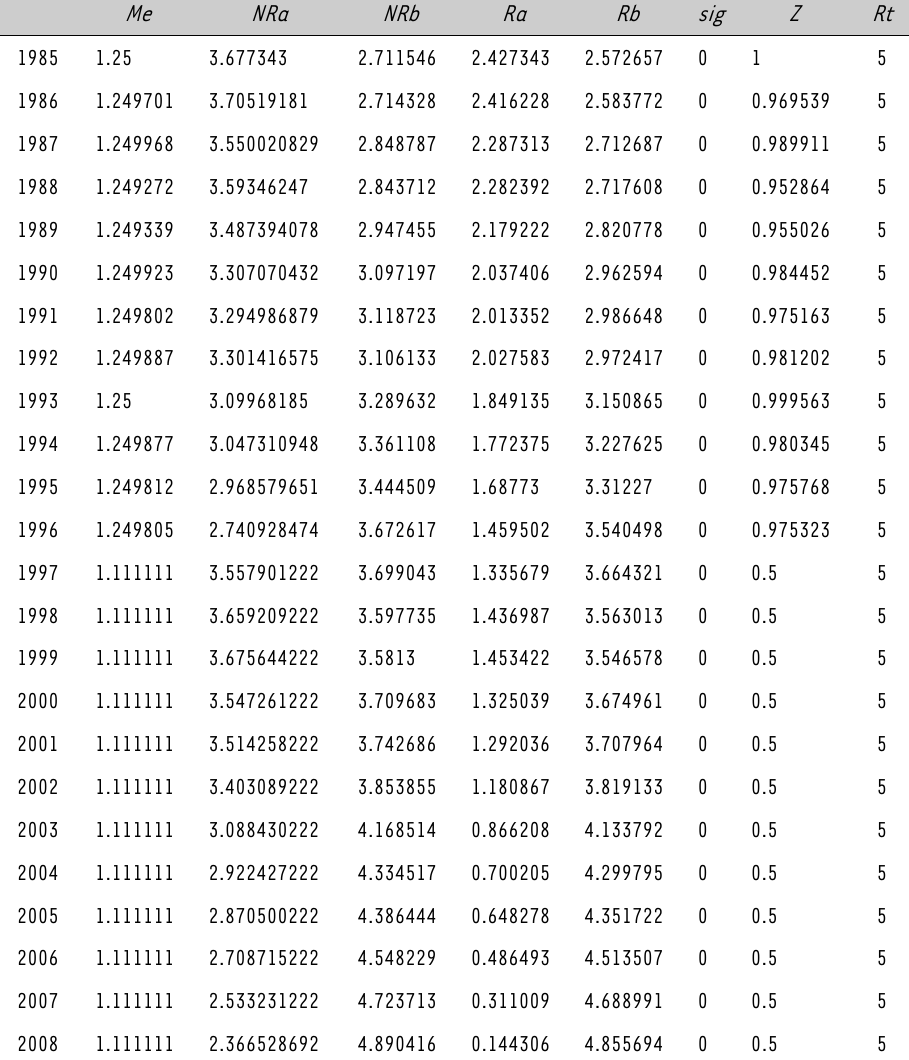
TABLE 5: Data used for South Africa to examine the reaction function between the ‘environmentalist’ and the ‘energy